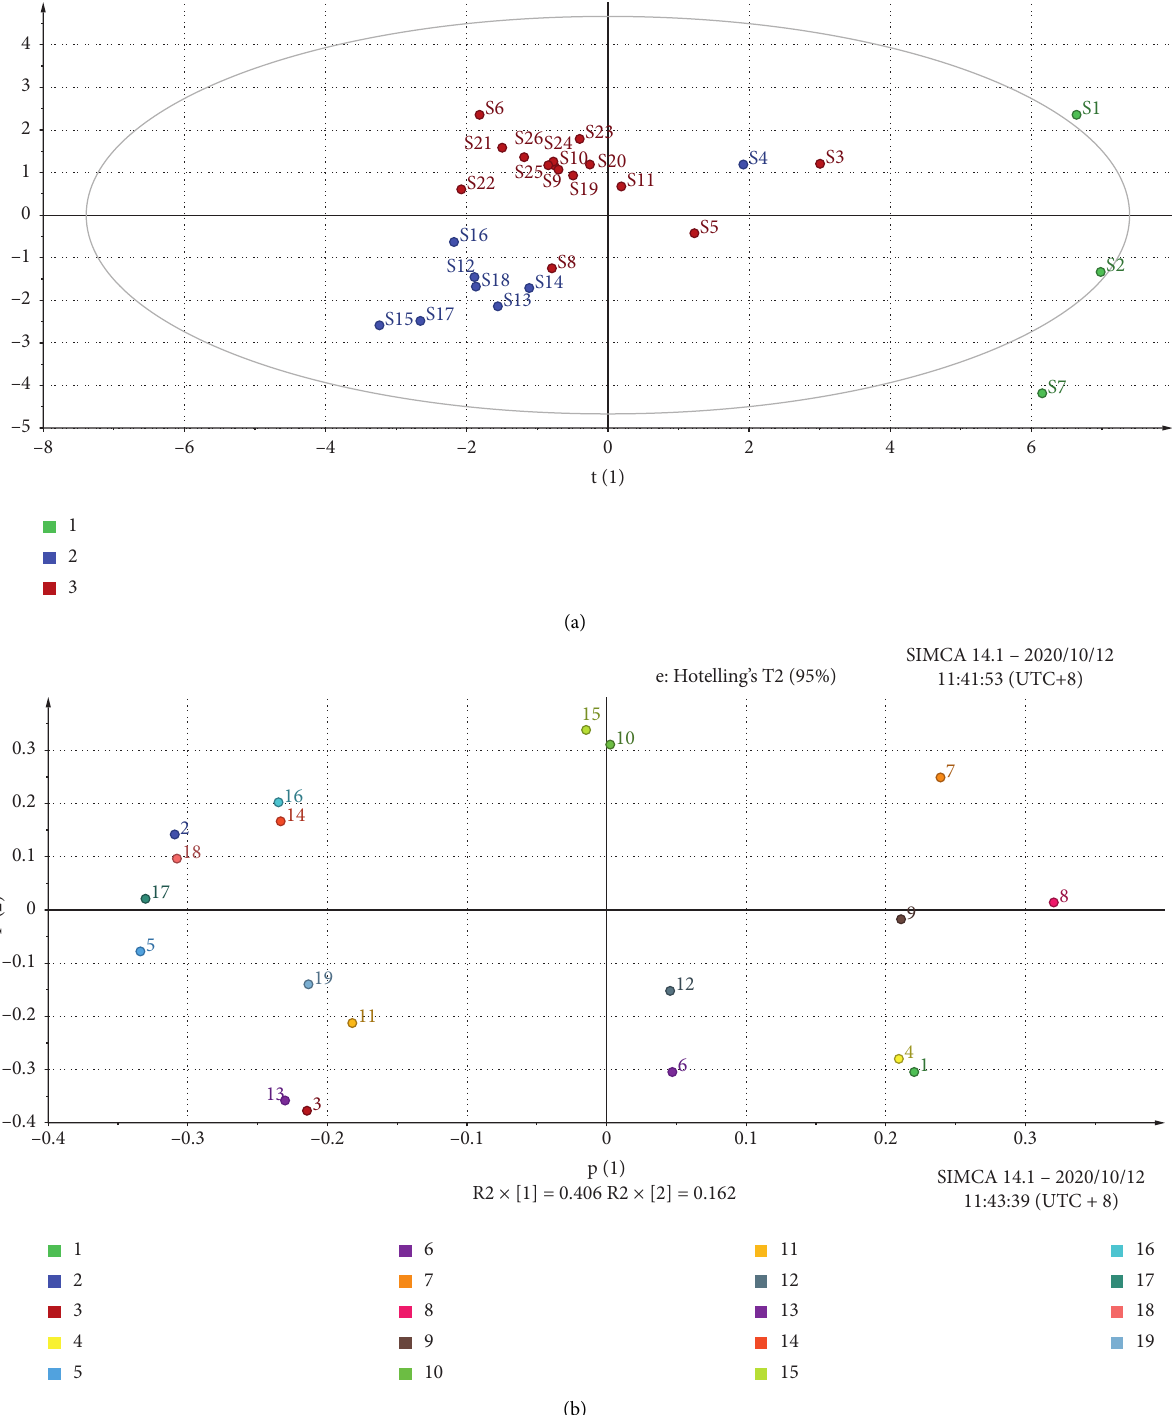
Figure 4: The score plot of the PCA for the 26 samples (a) and the loadings plot of PCA for 26 characteristic peaks